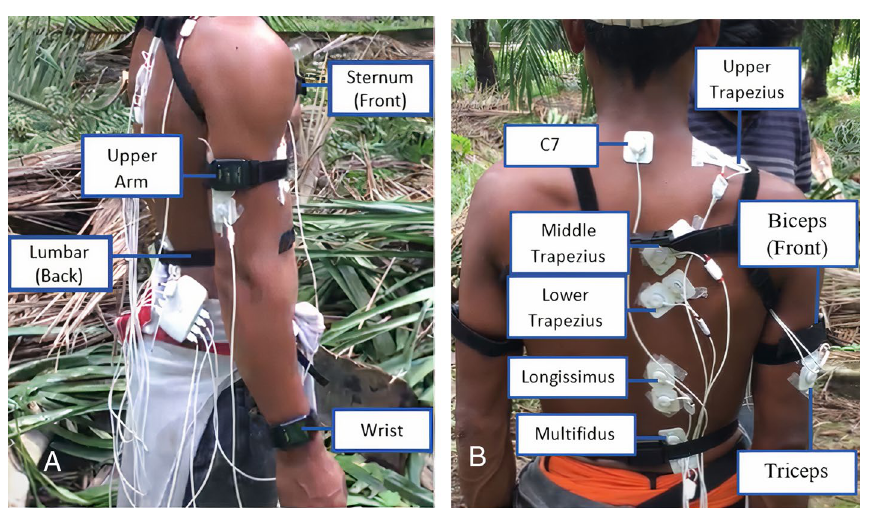
Figure 2. IMU Sensor placement ( A ) and EMG Sensor placement ( B ) on Harvester’s